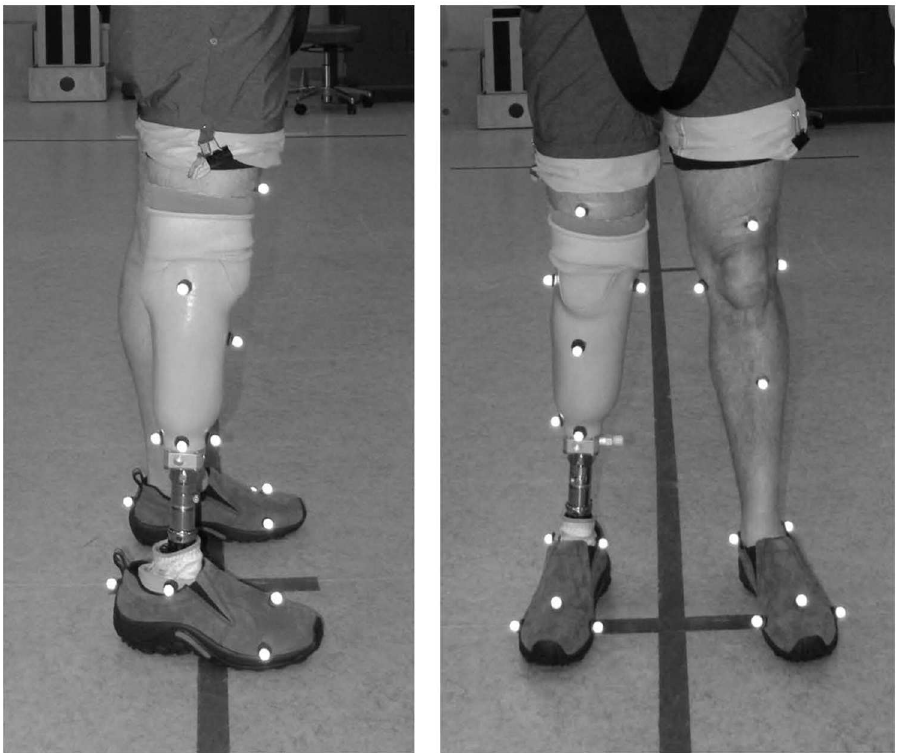
Fig 3. Markersplaced on the distal end of the socket were used to define a socket coordinate